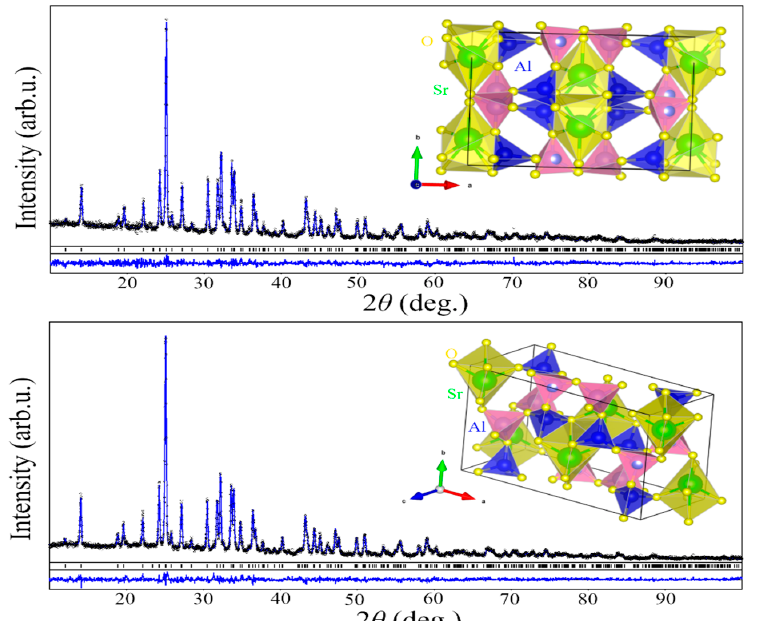
Figure 6. Graphical results of Rietveld refinement of SrAl 4 O 7 :Cr 3+ (top) and SrAl 4 O 7 :Mn 4+ (bottom) structures with x = 0.005. Experimental XRD patterns (black circles) are shown in comparison with calculated ones. Short vertical bars indicate positions of Bragg’s maxima in grossite ‐ type C2/c structure. Insets show polyhedral views of SrAl 4 O 7 structure in two different projections. The a , b , and c indicate corresponding crystallographic axes.